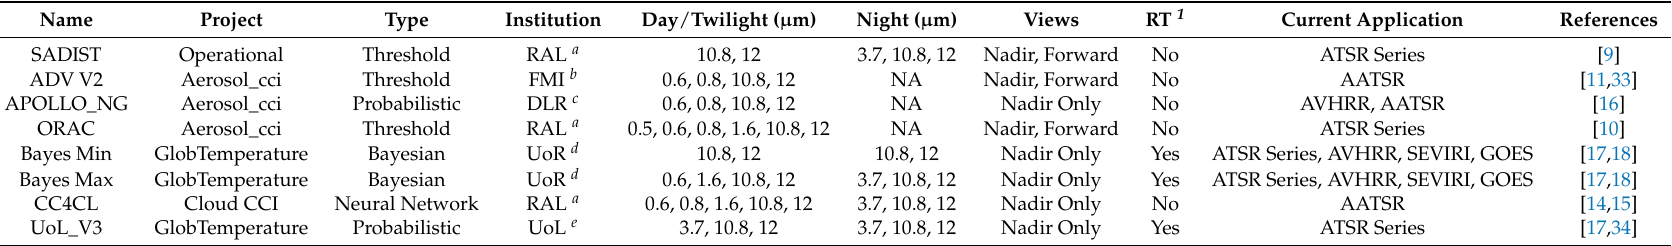
Table 2. Key characteristics of the cloud detection algorithms submitted to the GlobTemperature Cloud Clearing Inter-Comparison exercise. Expansion of algorithm acronyms are as follows: Synthesis of ATSR Data Into Sea-Surface Temperature (SADIST); AATSR Dual View V2 (ADV 2); the Avhrr Processing scheme Over Land, cLouds and Ocean-Next Generation (APOLLO_NG); Optimal Retrieval of Aerosol and Cloud (ORAC); Bayesian Cloud Detection (Bayes Min and Bayes Max); Community Cloud Retrieval for Climate (CC4CL); University of Leicester Version 3